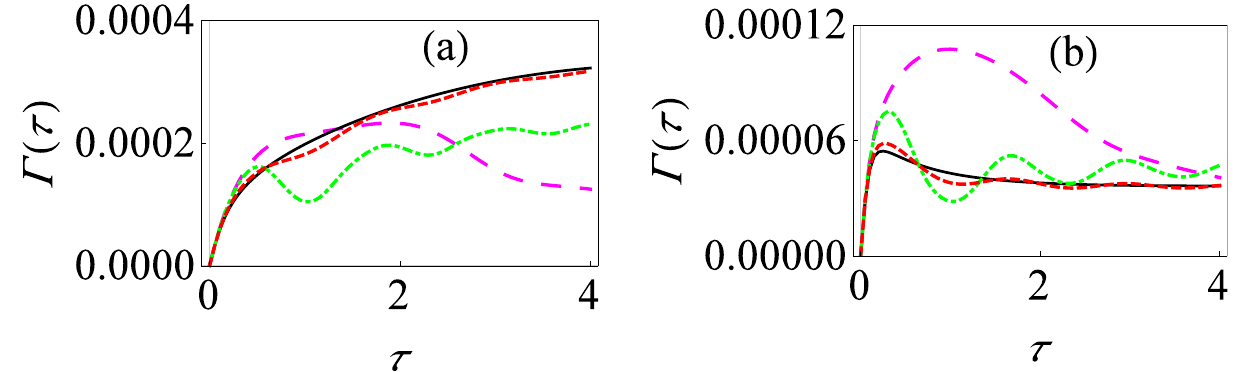
Figure 6. Effective decay rate for the strongly coupled driven spin-boson model. ( a ) Graph of Ŵ(τ) versus τ in the presence of the time-dependent driving fields: α( t ) 1 and (cid:31) 5 (dashed, red curve), V 0 V 0 = = (dot-dashed, green curve). The solid black curve shows α( t ) 10 and G 0.05 , ω c 1 . ( b ) Same as ( a ), except that now G (cid:31) = = =